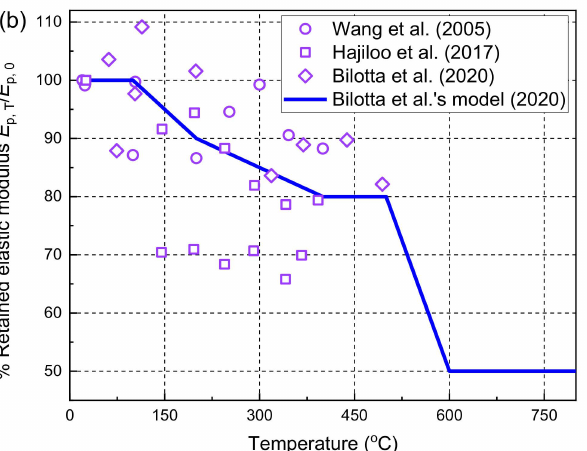
Figure 3. Retained mechanical properties of GFRP bars at high temperatures: ( a ) tensile strength; ( b ) elastic modulus